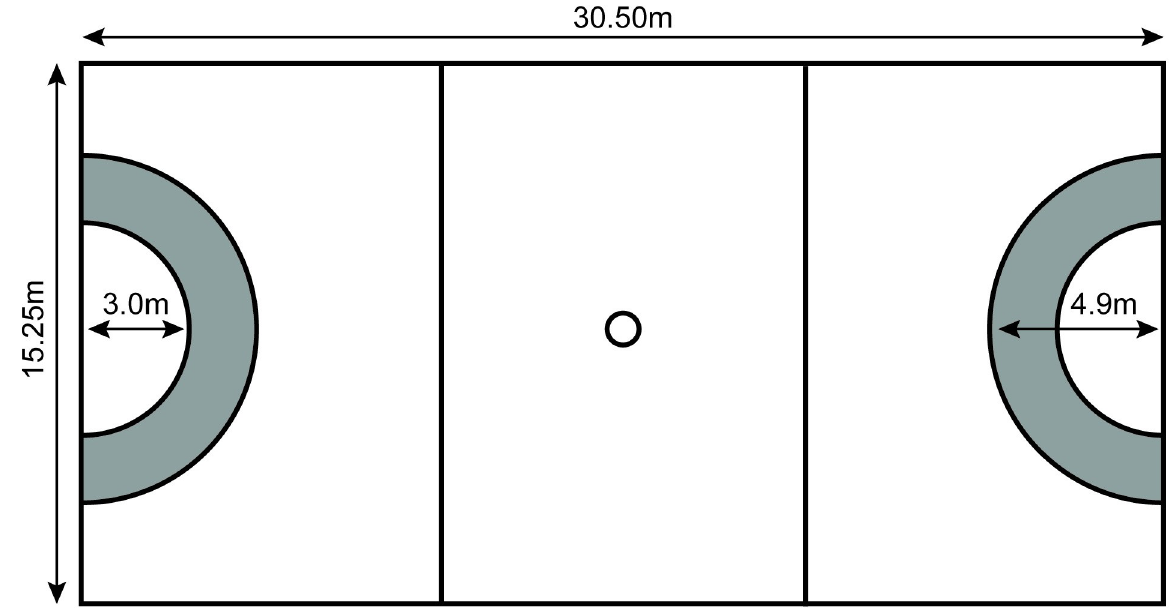
Fig 1. Netball court schematic with the new ‘outer-circle’ (highlighted in grey) where a two-point shot will be available for the final five minutes of